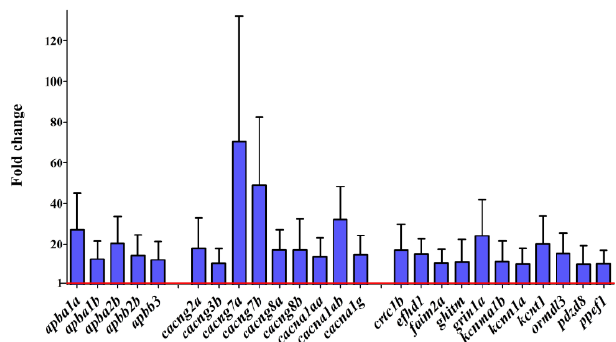
Figure 6. The changes in the expression of selected CaTK genes between mature fish and 5dpf larvae, quantified by RT-PCR arrays: Only genes with a fold change >10 and p < 0.05 are shown (Tukey’s Honestly Significant Difference test). The normalized expression in larvae was used as a reference value (= 1, marked as a red line). The data are presented as a fold change ± SD, normalized to the expression level in 5 dpf larvae ( n = 3).